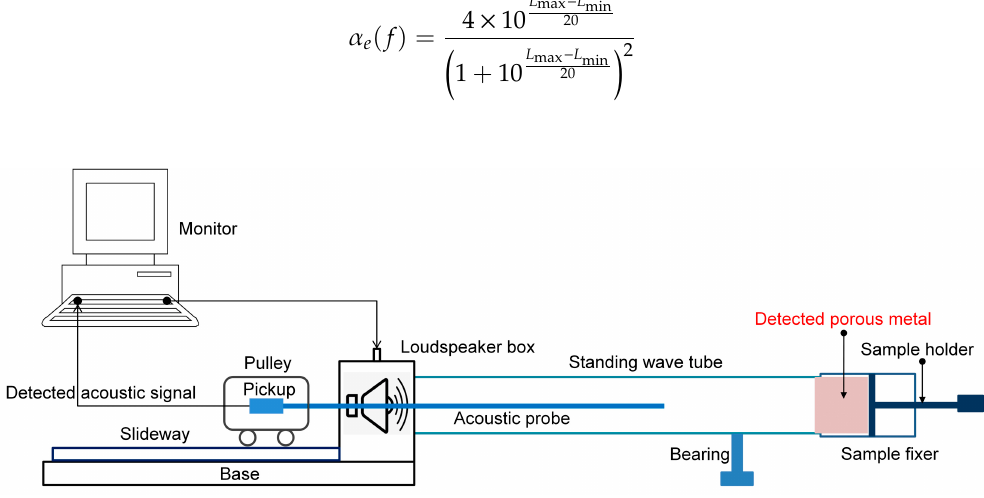
Figure 2. Schematic diagram of the standing wave tube measurement by AWA6128A detector.